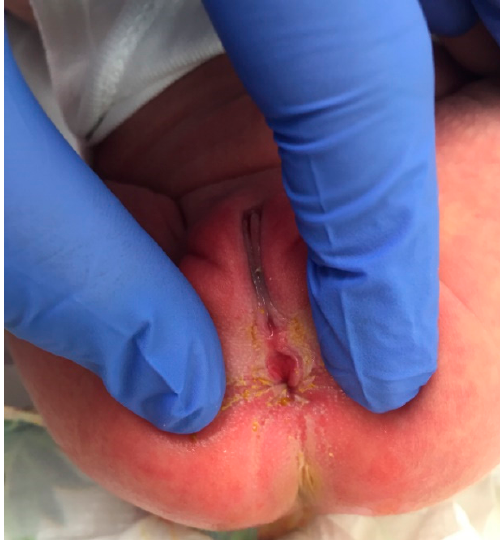
Figure 2. Perineal groove in a 15-day old patient.